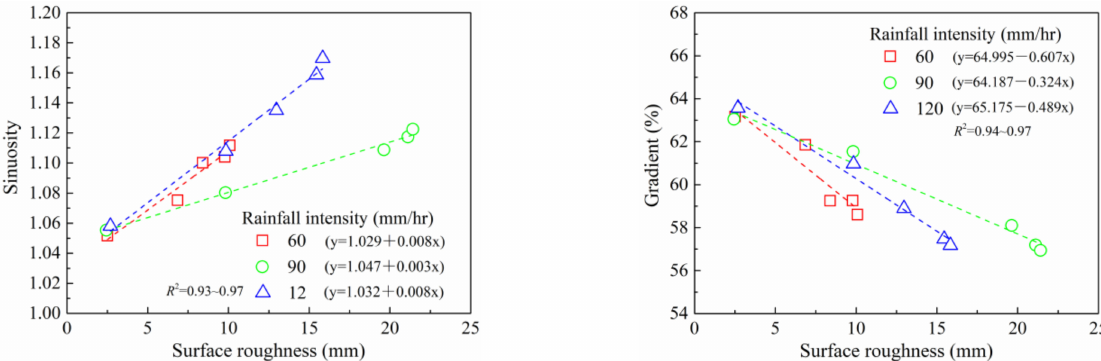
Figure 10. Relationships between surface roughness, stream sinuosity, and stream gradient.